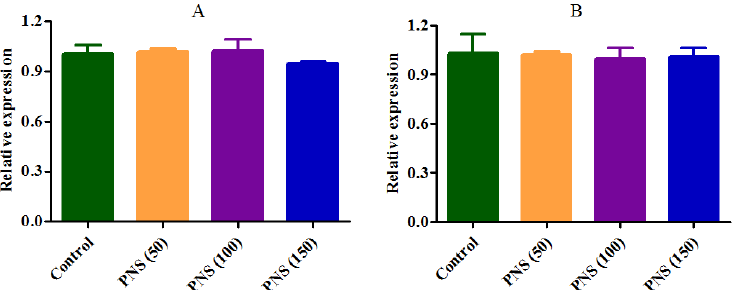
Figure 9. Effects on mRNA expression of human carboxylesterase 1 (hCE1) ( A ) and hCE2 ( B ) following Panax notoginseng saponins (PNS) treatment. Cells were incubated with PNS for up to 24 h. After the removal of PNS, total mRNA was prepared for qRT-PCR. Data were presented as mean ± SD ( n = 3).